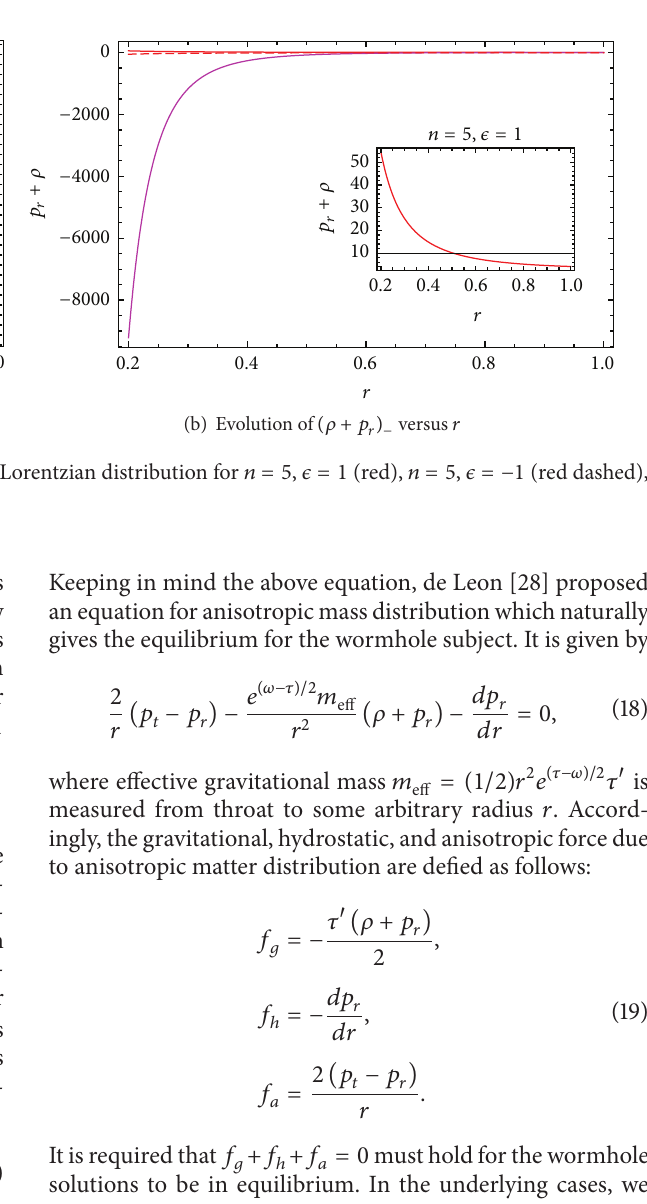
Figure 6: Plots of (a) 𝜌 + and (b) 𝜌 − versus 𝑟 in Lorentzian distribution for 𝑛 = 5 , 𝜖 = 1 (red), 𝑛 = 5 , 𝜖 = −1 (red dashed), and 𝑛 = 6 , 𝜖 = 3 (purple). For (a) 𝜌 + , 𝑛 = 6 , and 𝜖 = −3 (purple dashed).